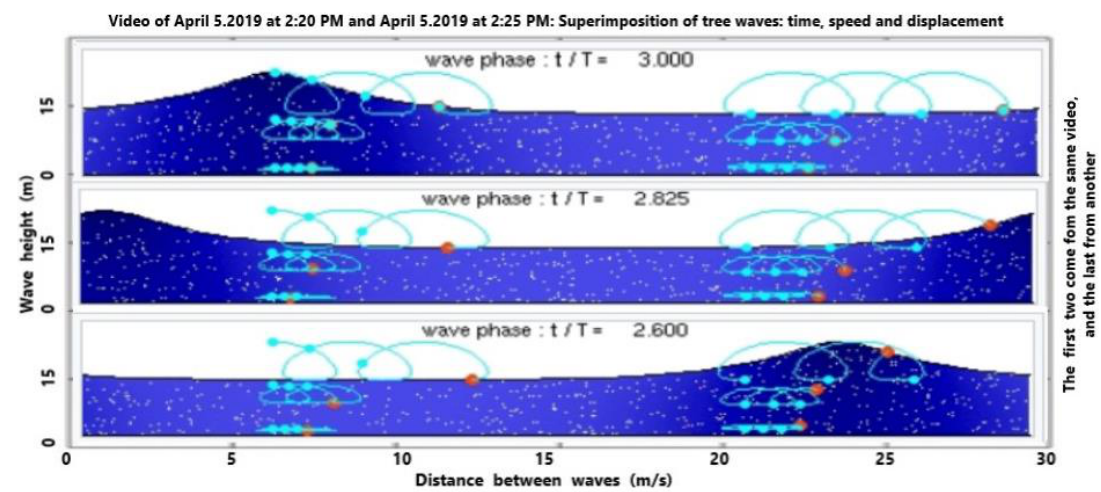
Figure 11. Output frames of processed overlapped wave propagation with 3D-CNN illustrating transport phenomena.